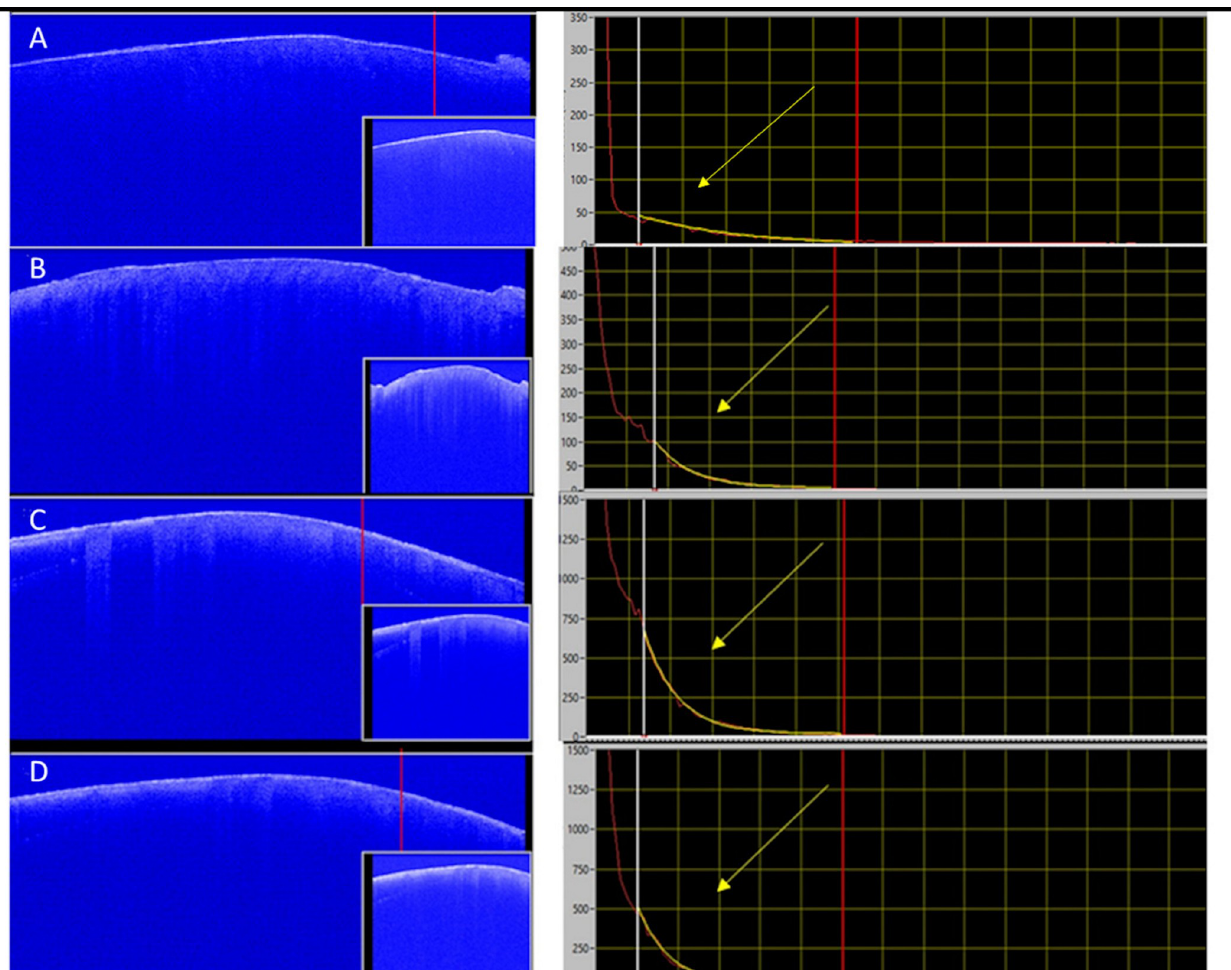
Fig 3. Exponential decay of the OCT signal obtained from one sample through the pH cycling (yellow arrows). A) Baseline B) Day 5; C) Day 10; D) Day 15. The software calculated the optical attenuation coefficient (OAC) of the ROI (Region of Interest—delimitated between the white and red lines in the left), as seen as a yellow curve in the right